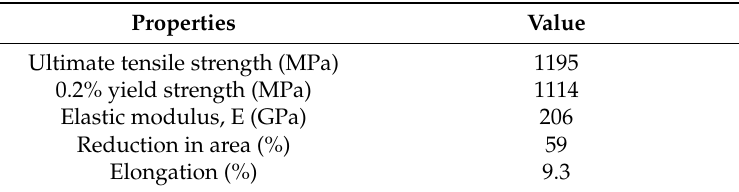
Table 2. Mechanical properties for AISI